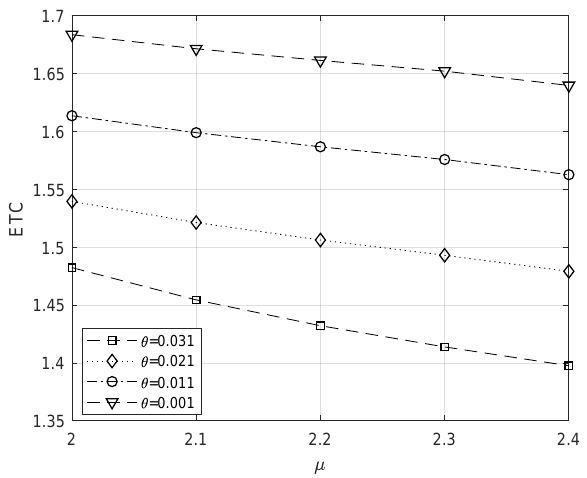
Figure 4. The impact of ETC when θ vs µ . for